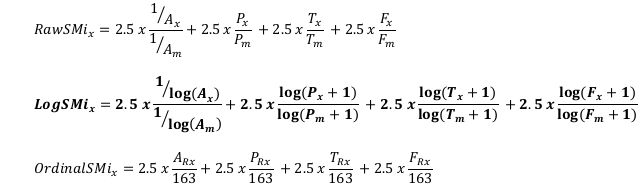
Figure . Formulas used for Social Media index (SMi)